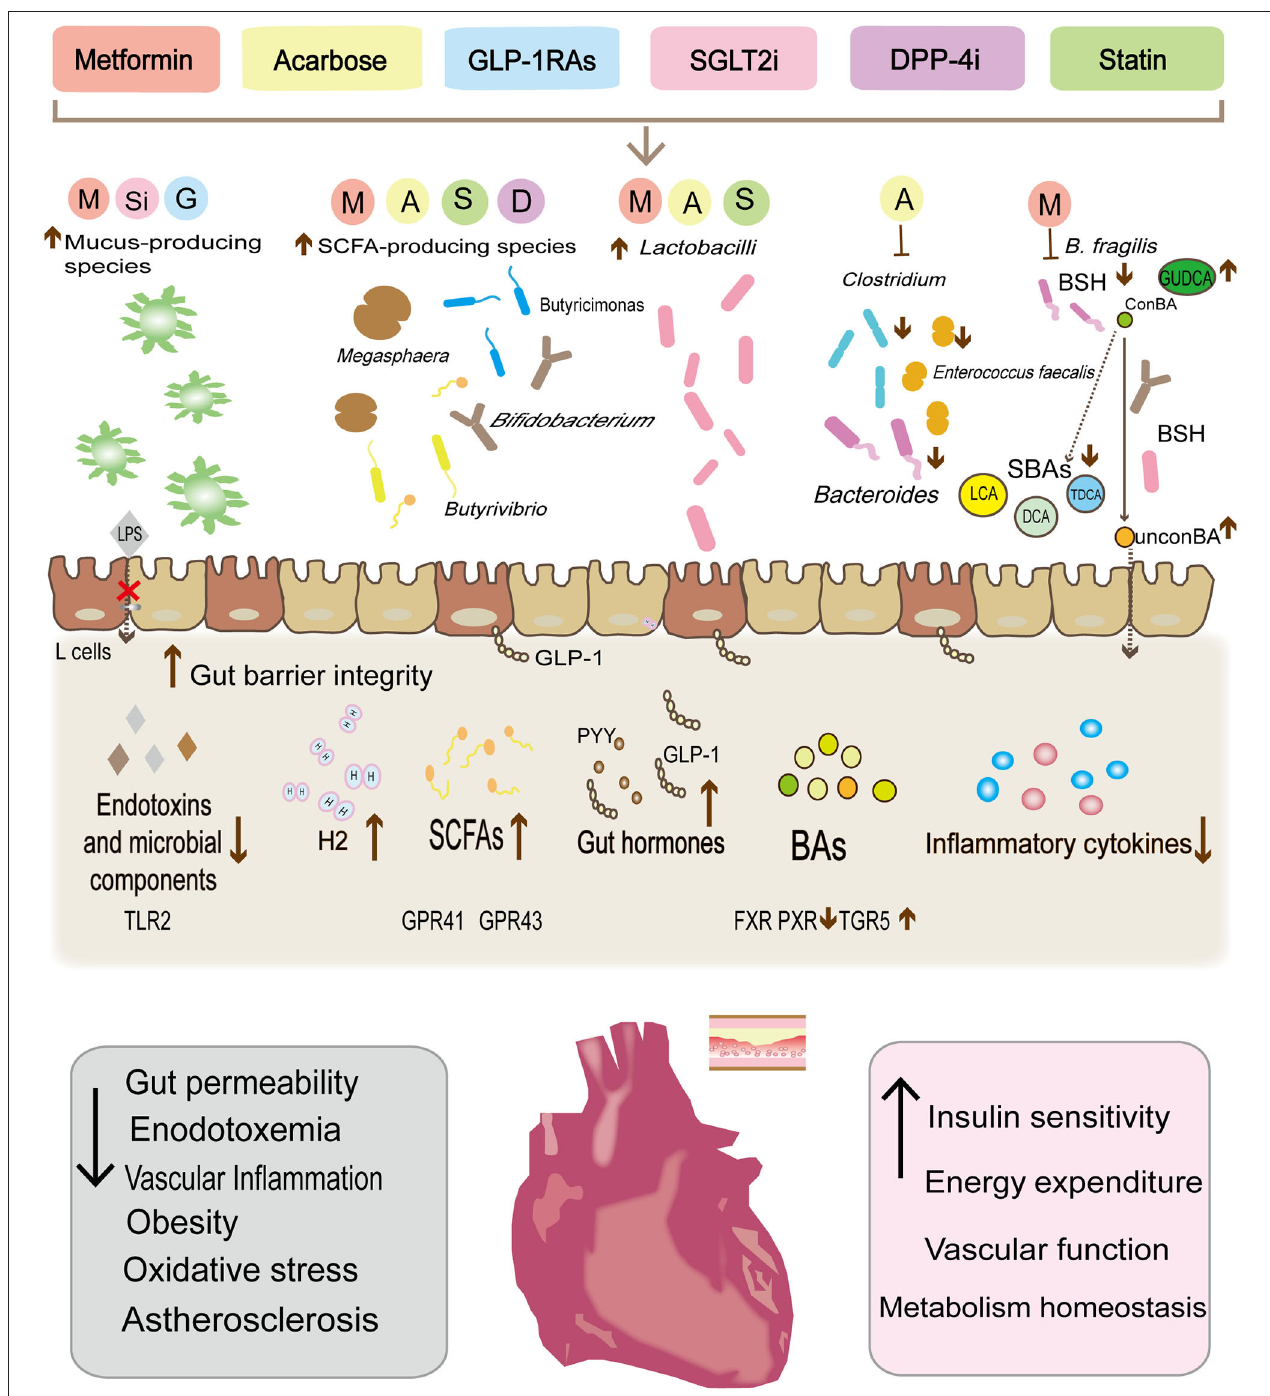
FIGURE 1 | Metabolic therapy drugs reshape the gut microbiota composition, modulate the abundance of specific gut bacteria, and then control the release of the microbial derivative to achieve cardiovascular protection and reduce cardiovascular risk factors. Metformin, liraglutide, and dapalizine have been found to increase the abundance of Akkermansia muciniphil , which can enhance the function of the intestinal barrier, limit endotoxin leakage. In parallel, the increase in the abundance of some species (Bacteroides, Butyricimonas, Lactobacilli, and Mucispirillum) after drug treatment has also been found to be significantly related to the decrease in secretion of pro-inflammatory cytokines (IL-18, IL-1 β , IL-16, and TNF α ). In turn, the decrease of the low-level inflammatory status has been shown to increase insulin sensitivity and benefit the vascular function. Similarly, both metformin and acarbose can reduce Bacteroides and Clostridium clusters, and may alter bile acid metabolism, with a reduction of bile acid reabsorption and secondary bile acids, thereby influencing the excitability of various atherosclerosis-related receptors (PXR, FXR, and TGR5) and stimulating GLP-1 secretion. Moreover, metformin, acarbose, liraglutide, rosuvastatin, and atorvastatin have also been found to increase